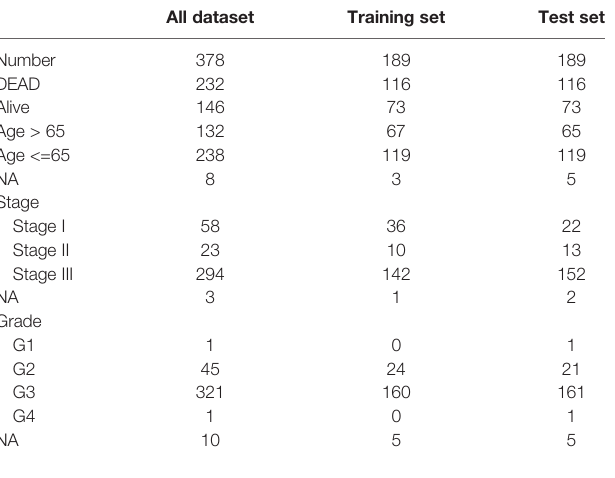
TABLE 2 | OV patient information (bulk RNA-seq).